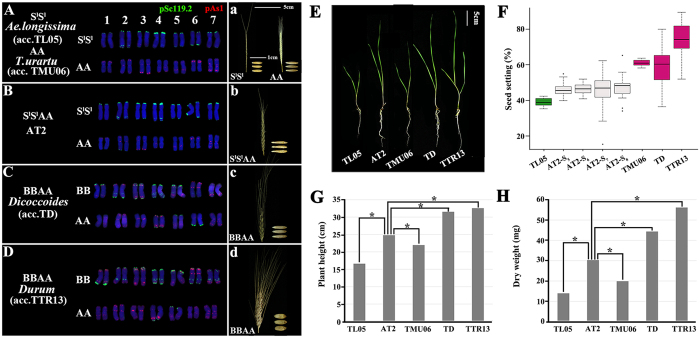
Sequential FISH-based karyotypes and typical phenotypes of the synthetic allotetraploid wheat (AT2) and its diploid parental species, along with the natural and domesticated tetraploid wheats.(A–D) are FISH images of the diploid parental species Ae. longissima (TL05) and T. urartu (TMU06), synthetic allotetraploid wheat AT2, a wild tetraploid wheat dicoccoides (TD), and a domesticated tetraploid wheat durum (TTR13), respectively. The probes used are pSc119.2 (green) and pAS1 (red). Images of (a–d) exemplify typical spike and seed morphologies of the Aegilops and wheat genotypes used in this study. (E–H) are typical seedling morphology, seed-setting rate, plant height and dry weight of AT2 relative to TL05, TMU06, TD, and TTR13. The Box blots (F) of different colors denote statistical significant differences (P < 0.05, pairwise t test). Statistical differences of pairwise comparisons in (G,H) are indicated by asterisks (P < 0.05, Student’s t test).